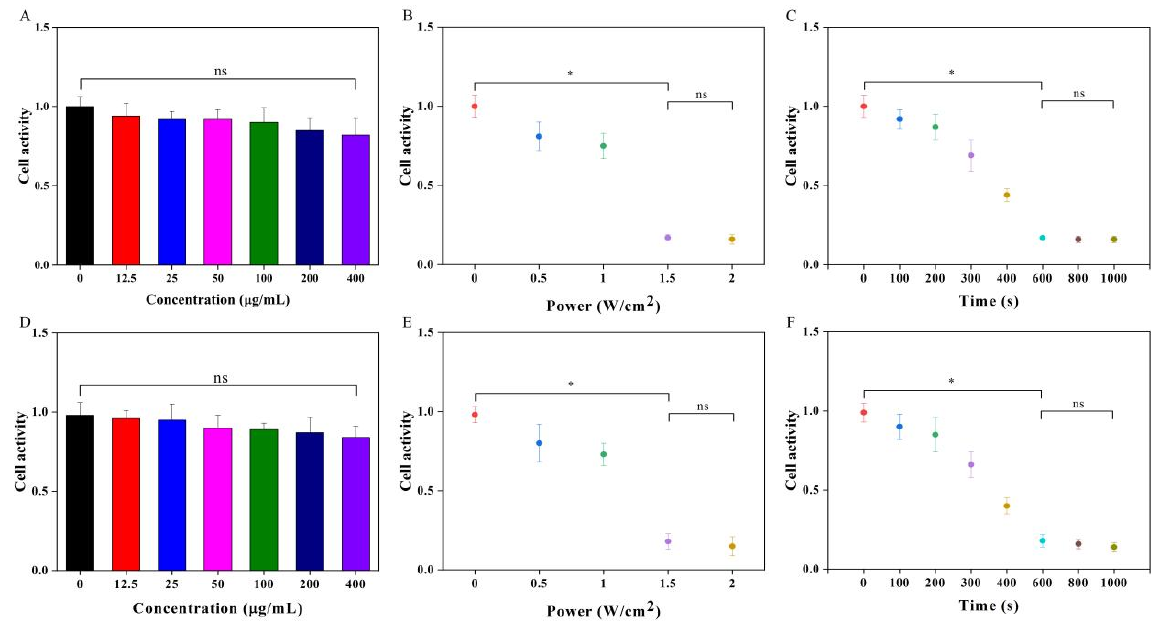
Figure 3. In vitro cytotoxicity assay. Viabilities of ( A – C ) prostate cancer cells (PC-3 cells) and ( D – F ) bladder cancer cells (MB49 cells) after treatment of HA-Au@SiO 2 @Au at ( A , D ) different NPs concentrations (12.5, 25, 50, 100, 200 and 400 μ g·mL − 1 ), ( B , E ) laser power densities (0.5, 1, 1.5, and 2 W·cm − 2 ), and ( C , F ) irradiation times (100, 200, 300, 400, 600, 800, and 1000 s). * p < 0.05, ns p > 0.05.